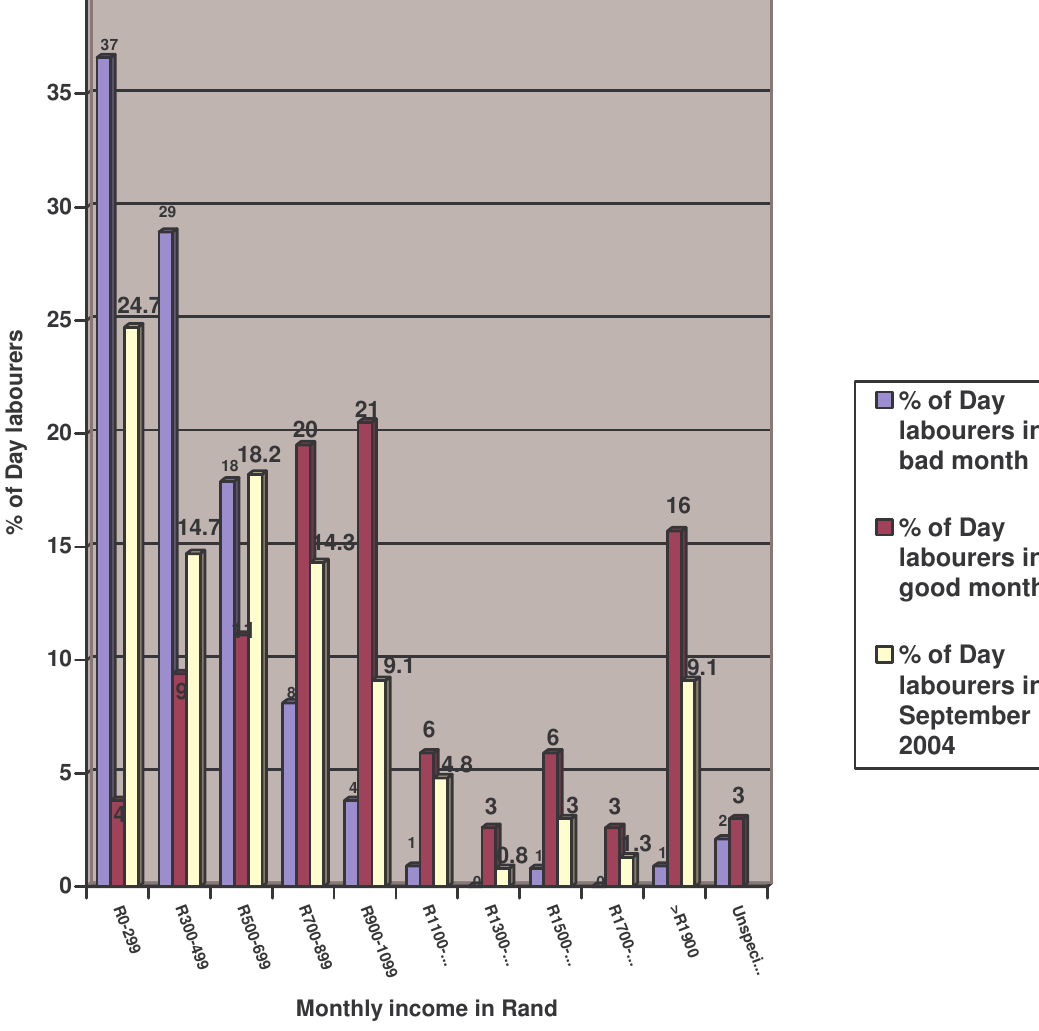
Figure 7: The monthly income of day labourers in Pretoria in August 2004, a good month and a bad month